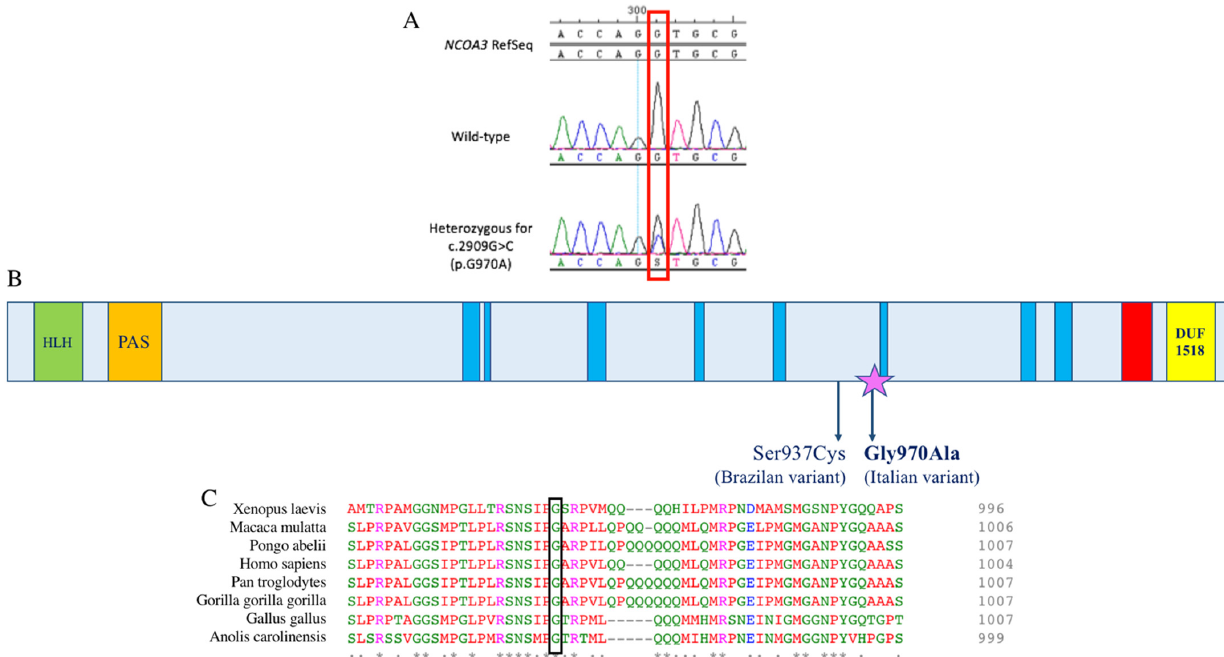
Figure 3. DNA chromatograms, schematic representation of the protein domains and protein alignment. ( A ) Chromatograms displaying part of the NCOA3 sequence; on top, the wild-type sequence is shown, and on the bottom, that of an affected individual carrying the variant at the heterozygous state. The red box indicates the position of the variant. ( B ) Schematic representation of NCOA3 protein domains and the localization of the two mutations associated with ADNSHL. The helix loop helix domain is displayed as a green box; in orange, the PAS motif; in blue, low-complexity regions; in red, the coiled coil region; and in yellow, the SMART DUF1518 domain, commonly found in receptor co-activating proteins. Both the variants detected in the NCOA3 gene and associated with ADNSHL are located in the same undefined region of the protein; the one found in the Italian family is indicated with a purple star. ( C ) Protein alignment showing conservation of residue G970 across species.